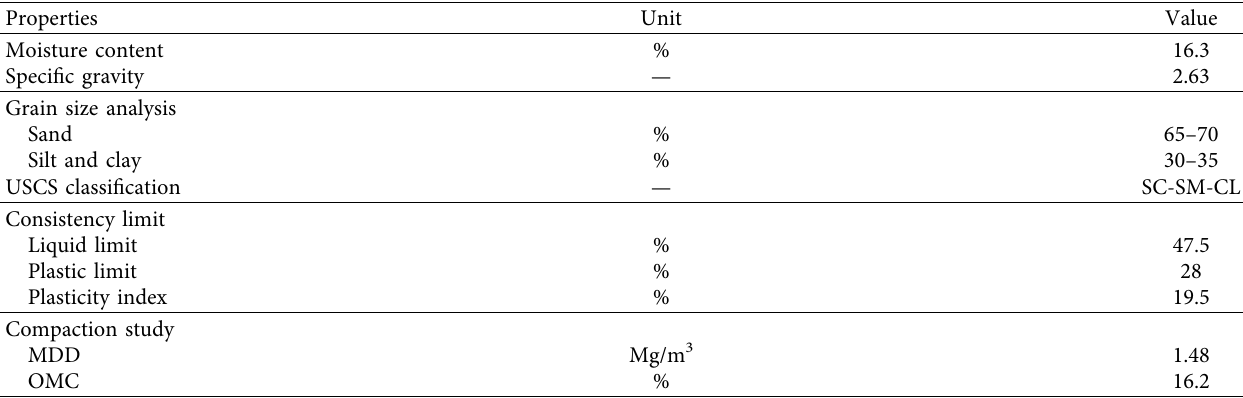
Table 1: Physical properties of West Coast soil.